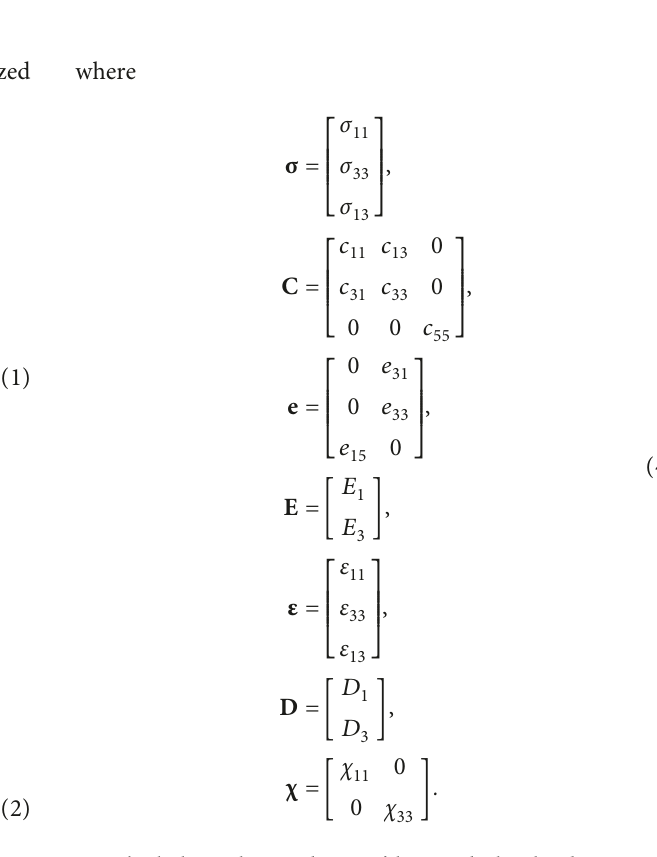
Figure 1: A PCMs beam: geometric parameters and Cartesian coordinate